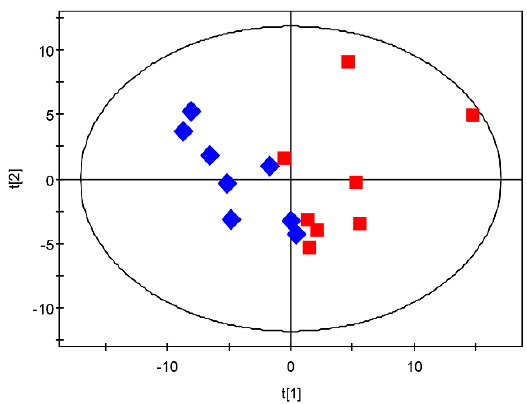
Figure 7. PCA scores derived from GC-MS spectra from isogenic strains GD-118P and GD-118P-V1 samples. Score plot of PCA: GD-118P (red square) and GD-118P-V1 (blue diamond).